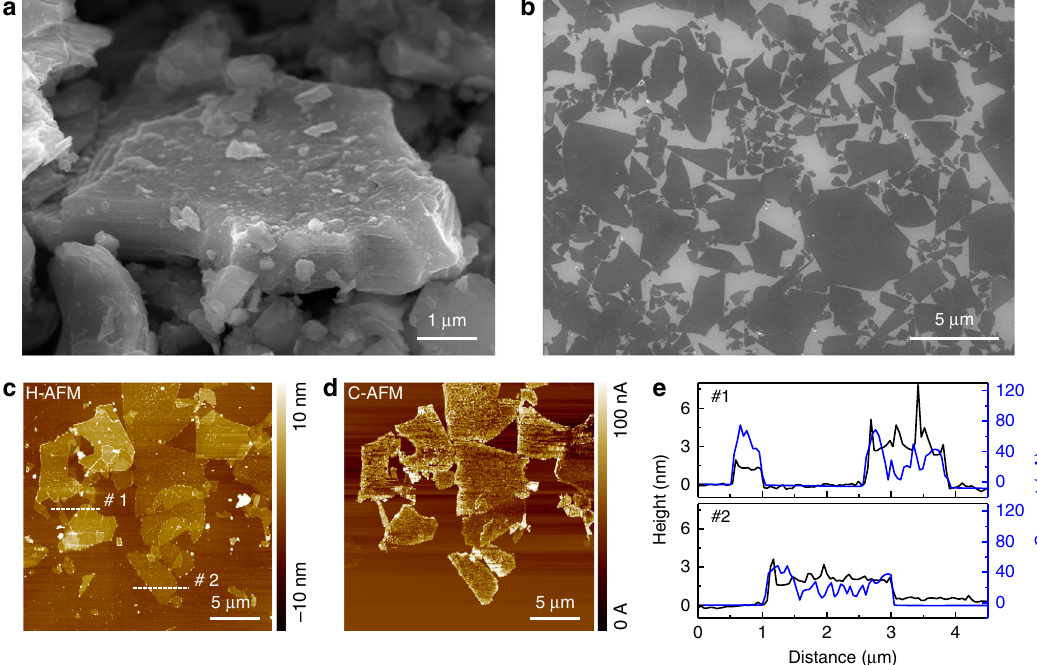
Fig. 2 Synthesis and identi fi cation of Ti 3 C 2 T x (MXene). Morphology of a MAX-phase particle and b MXene single layer coated on a SiO 2 wafer. c AFM and d C-AFM images of MXene single sheets in the same area. e Height and current-line pro fi le of lines #1 and #2 in c